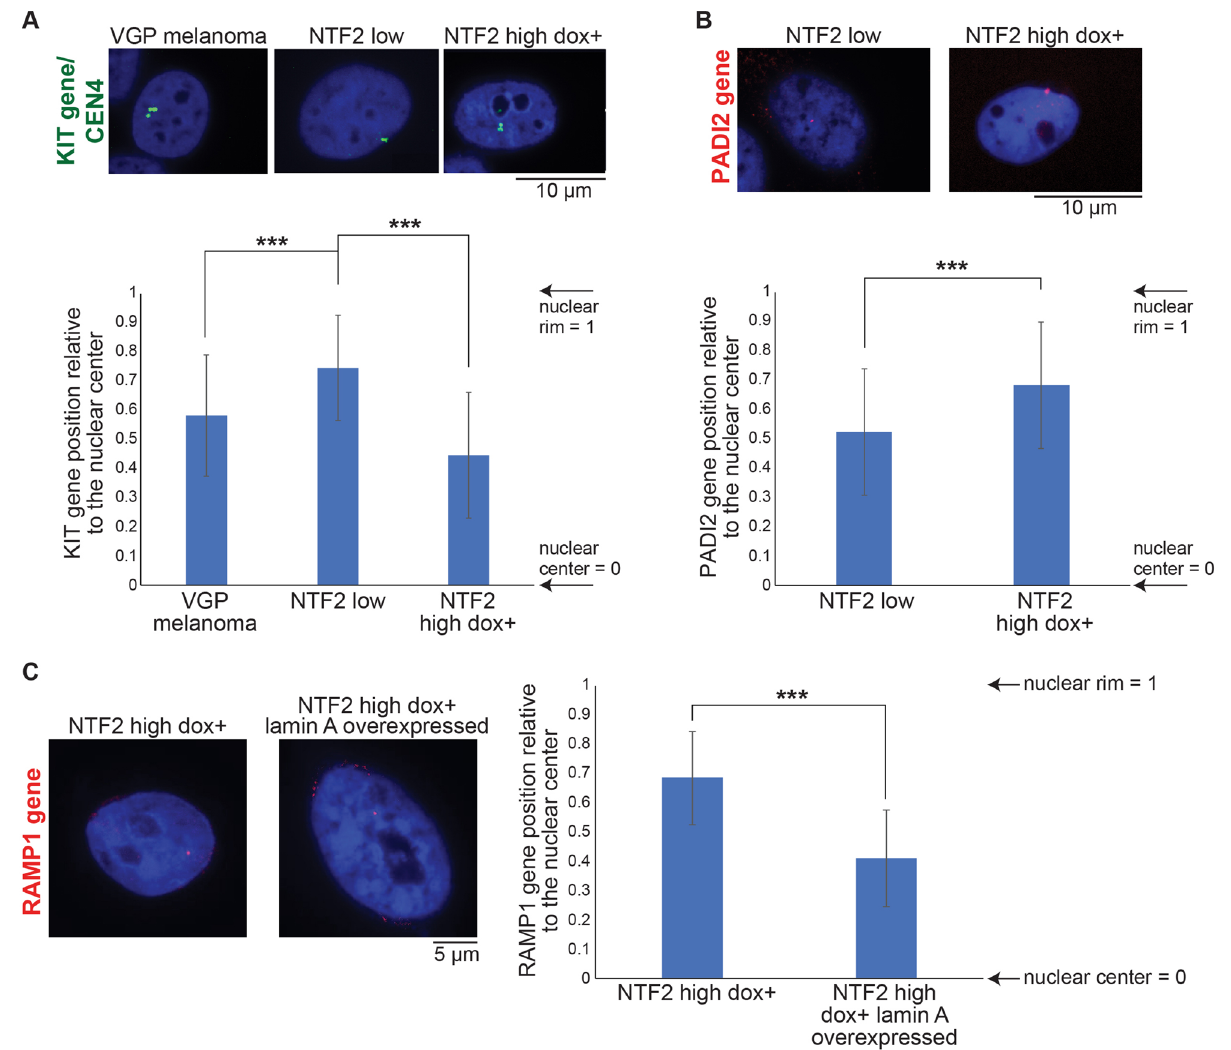
Figure 6. NTF2 levels affect gene positioning. (A) DNA FISH was performed for the KIT gene and the centromere of chromosome 4 (CEN4). The two signals overlapped and representative CEN4 images are shown due their stronger signal. Gene distance from the nuclear center was divided by the nucleus radius (see “Methods”). At least 30 nuclei were measured for each condition. Error bars are SD. One-way ANOVA followed by Dunnett’s multiple comparisons test with ***p < 0.0001. (B) DNA FISH was performed for the PADI2 gene and representative images are shown. Gene distance from the nuclear center was divided by the nucleus radius (see “Methods”). At least 30 nuclei were measured for each condition. Error bars are SD. Two-tailed Student’s t-test assuming equal variances with ***p < 0.0001. (C) NTF2 high cells were transiently transfected to overexpress lamin A. Control and transfected cells were treated with 20 ng/ml doxycycline for 48 h. DNA FISH was then performed for the RAMP1 gene and representative images are shown. Gene distance from the nuclear center was divided by the nucleus radius (see “Methods”). At least 30 nuclei were measured for each condition. Error bars are SD. Two-tailed Student’s t-test assuming equal variances with ***p <